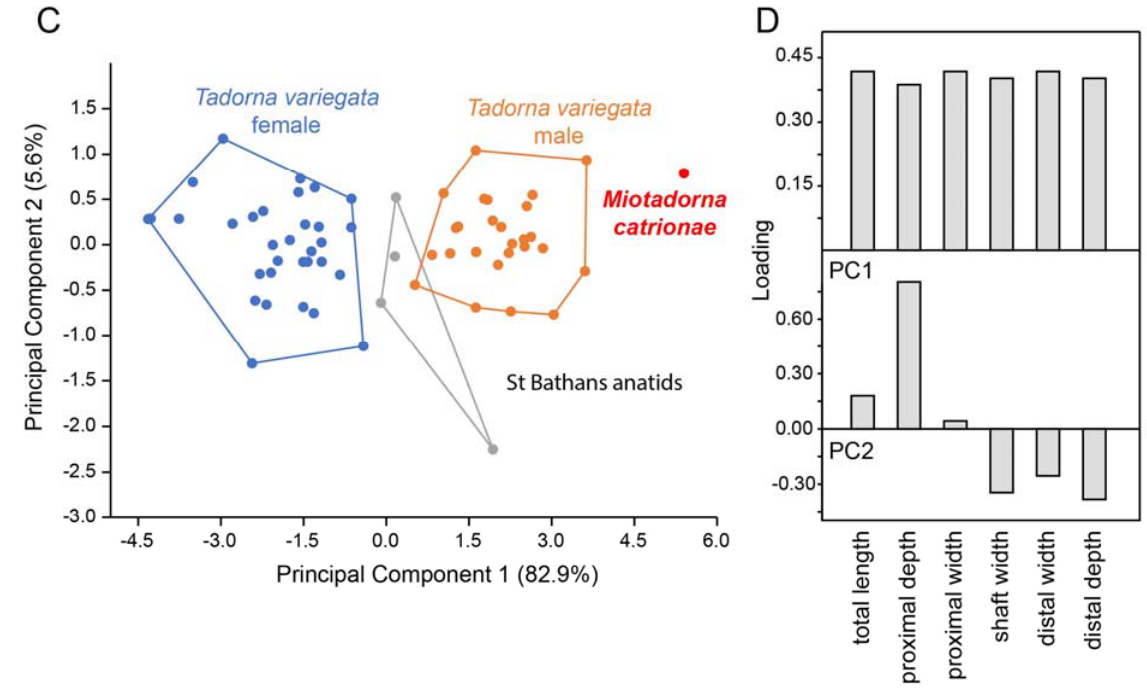
Figure 1. Right holotype humeri of Miotadorna catrionae sp. nov. (NMNZ S.47273, left) and Miotadorna sanctibathansi (NMNZ S.42794, right) in different views: ( A ) caudal, ( B ) cranial, showing features referred to in the text. Measurements (in mm) for individual bone sections in ( B ) are as follows: i, 33.0; ii, 31.8; iii, 23.0; iv, 21.4; v, 33.3; total = 142.5. ( C ) PCA plot showing the first two principal components. The amount of variance explained per component is shown in parentheses. ( D ) Loadings for the first two principal components.